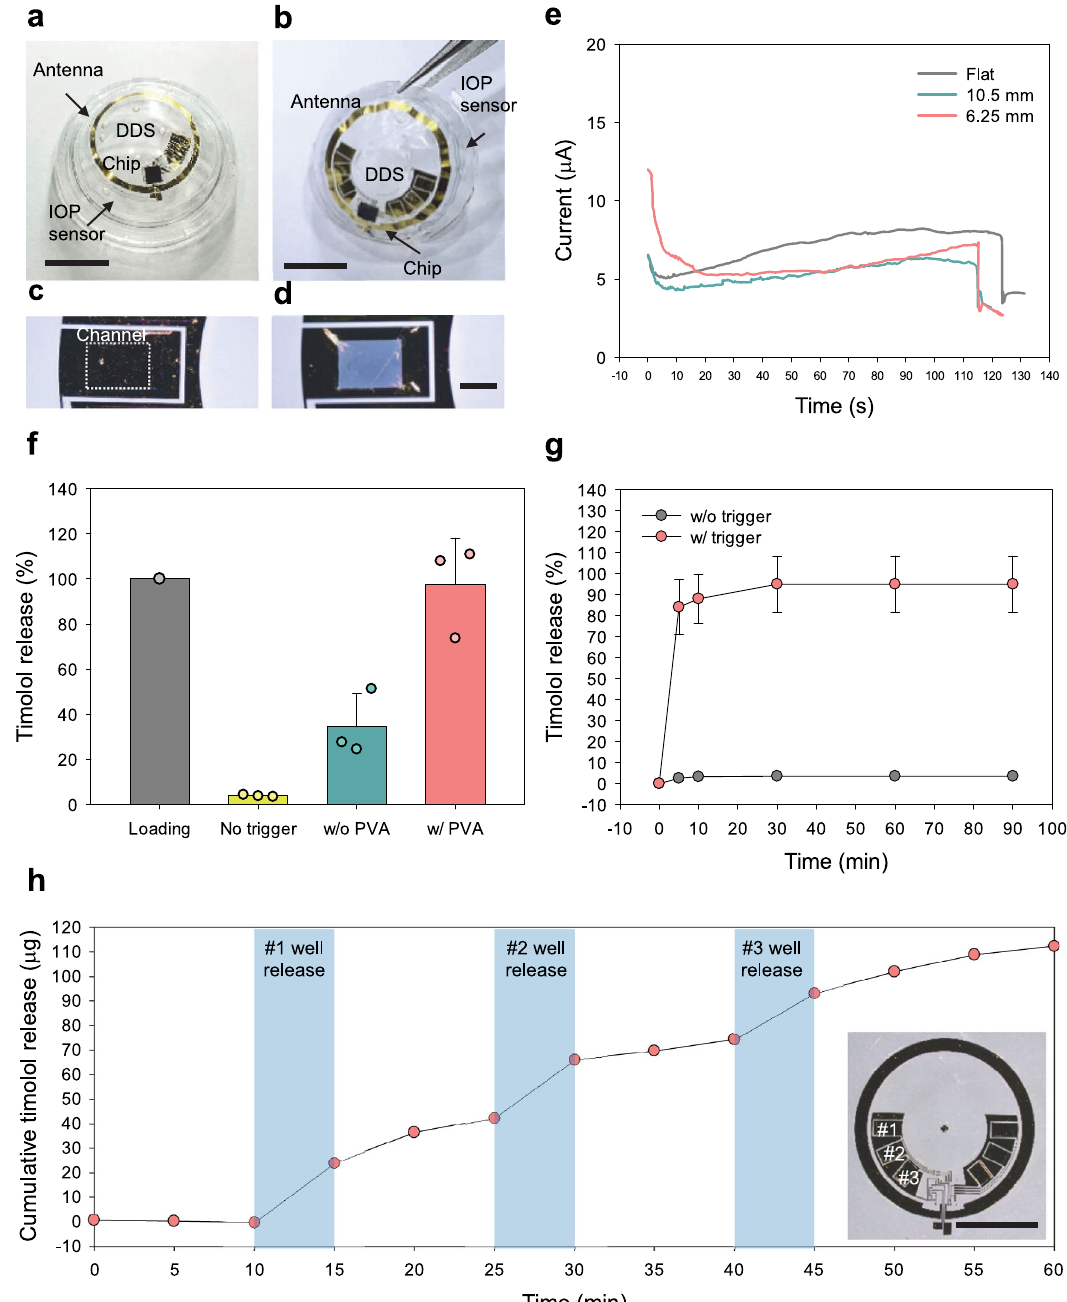
Fig. 4 | Characteristics of fl exible DDS. Optical images of a daily and b weekly types of theranostic smart contact lenses (scale bar, 5.5mm). c Before and d after the selective electrochemical dissolution of the gold channel in PBS (scale bar, 400 μ m). e I – t curve of fl exible DDS with different bending conditions. f In